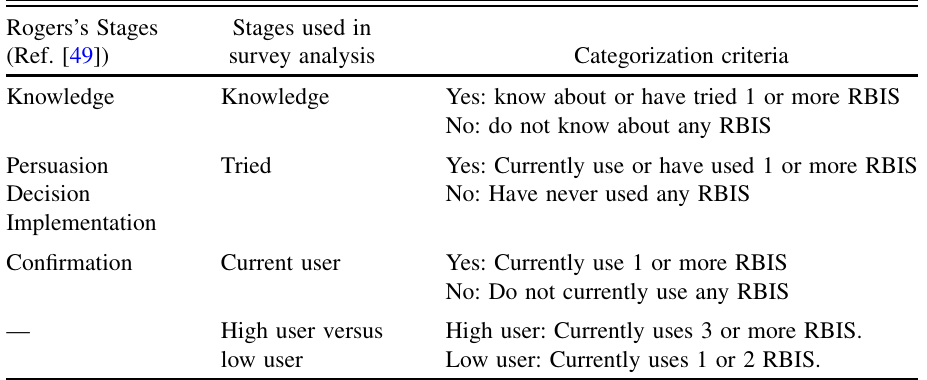
TABLE III. Stages in the innovation-decision process. Rogers’s